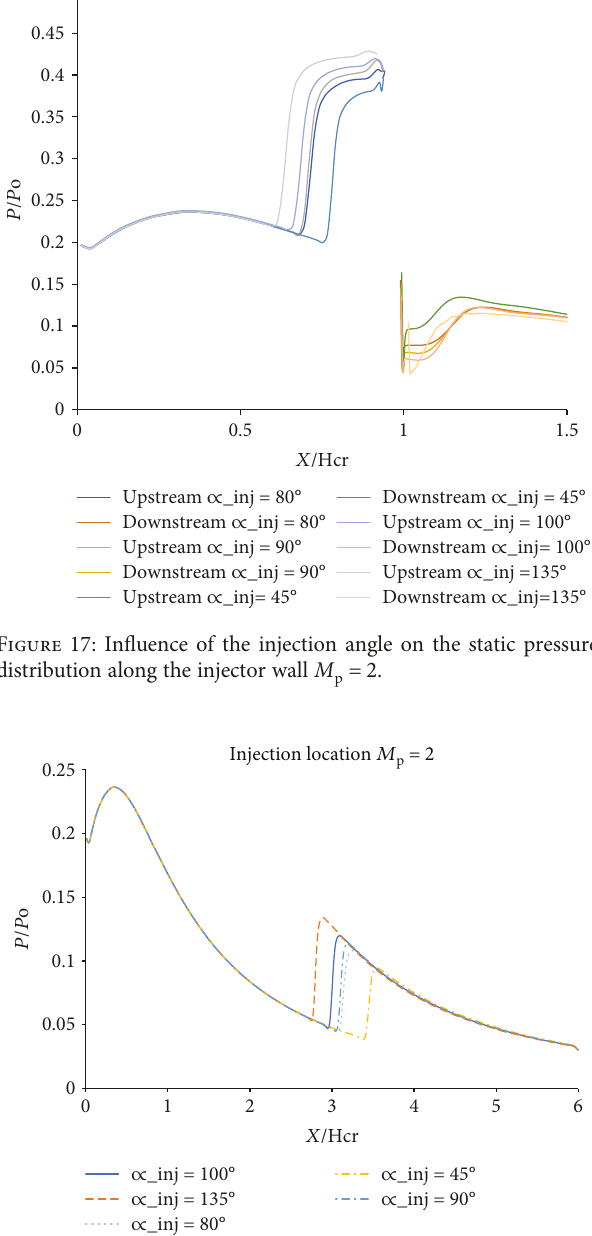
Figure 18: In fl uence of the injection angle on the static pressure distribution along the lower wall M